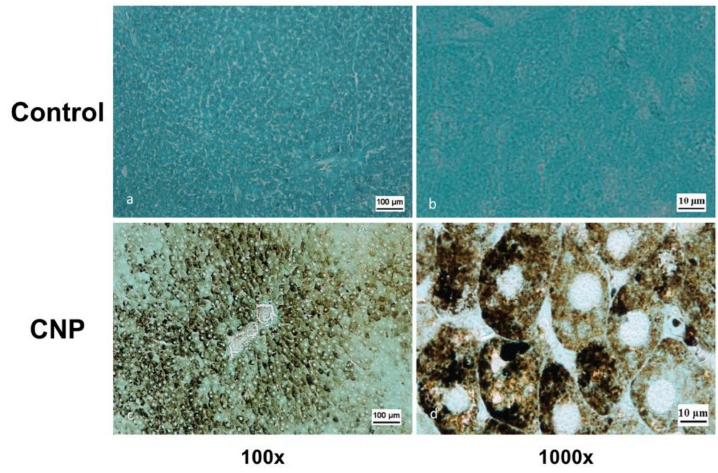
Figure 14. Rat livers 2 h after administration of CNP suspension (16 mg / kg). Grocott’s staining technique: ( a ) hepatocytes of control group (100 × ), ( b ) the same hepatocytes at magnification 1000 × ; ( c ) CNP group, hepatic lobule, area of the central vein, hepatocytes with internalized CNPs (100 × ); ( d ) the same hepatocytes at magnification 1000 × .